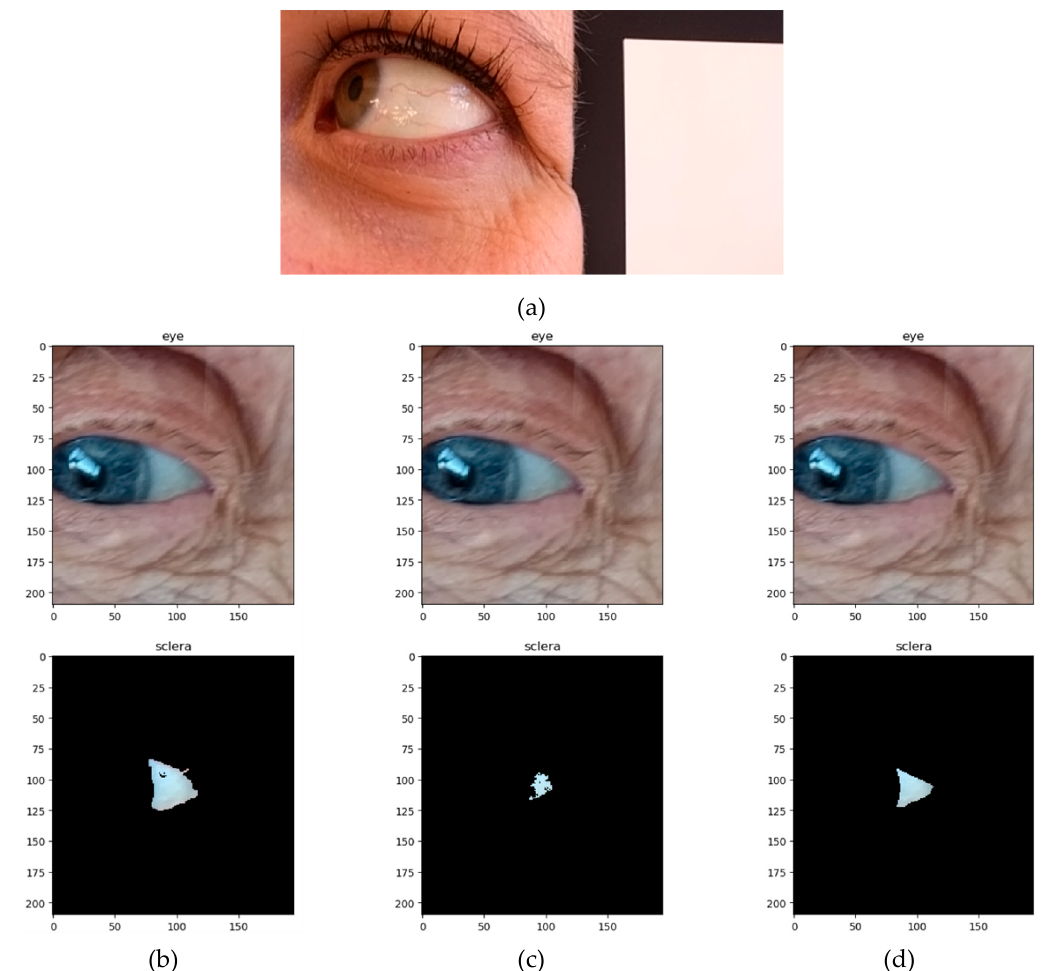
Figure 1. Examples of eye pictures taken during the study. ( a ) Native image of a 37-year-old woman without ID and no blue sclera with the white patch of the color checker. ( b–d ) Native and post-processed pictures of an 86-year-old woman with blue sclera and ID, according to the method for sclera delineation. ( b ) Automated method (full sclera, FS); ( c ) semi-automated method (semi-automated sclera, SAS); and ( d ) manual method (manual sclera, MS).